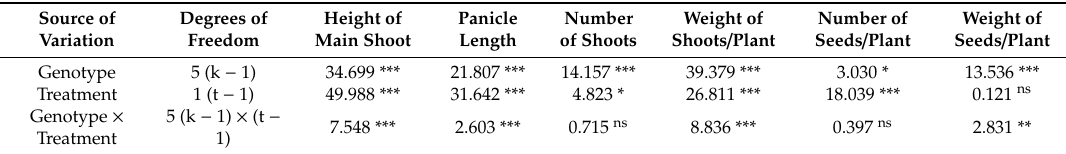
Table 5. F -statistic from two-way analysis of variance for selected traits of studied genotypes (OMA lines and cv.